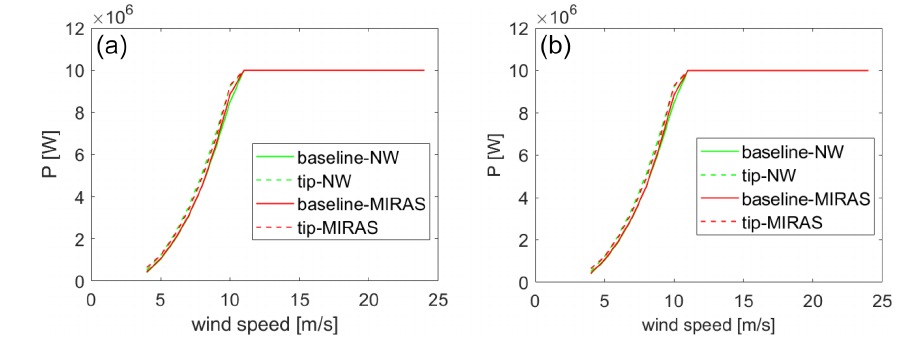
Figure 12. Power curve comparison between HAWC2-NW and HAWC2-MIRAS: (a) class I and (b) class III. Solid lines represent the baseline blade, while dashed lines represent the optimized tip design.